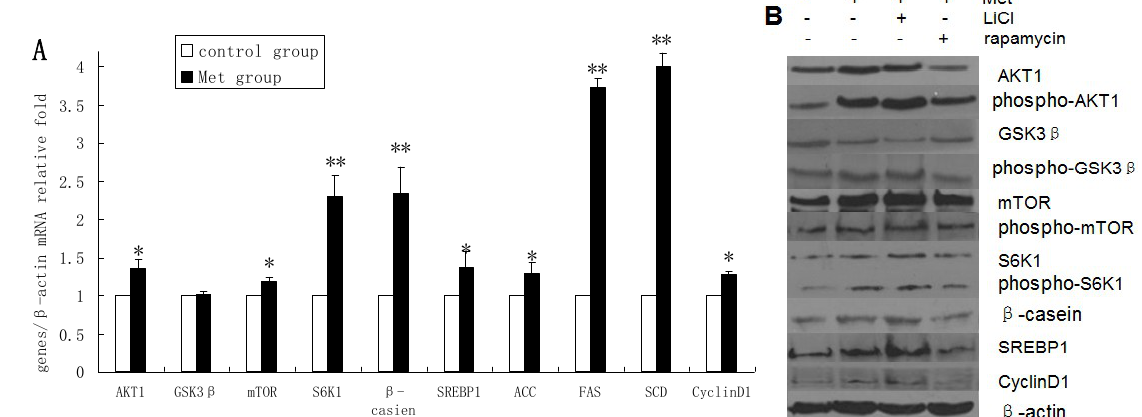
Figure 4. Assessments of gene expression, protein expression, cell viability, cell proliferation, cell cycle, and triglyceride (TG) secretion in four groups of DCMECs: control (untreated) cells, DCMECs treated with Met (0.6 mM) for 24 h, DCMECs treated with Met (0.6 mM) and LiCl (20 mM) for 24 h, and DCMECs treated with Met (0.6 mM) and rapamycin (1 nM) for 24 h. Relative mRNA levels (mRNA levels/ β -actin) were determined by qRT-PCR following Met treatment ( A ) and protein levels were assessed by western blot analysis ( B ) and quantified (proteins/ β -actin relative fold) by gray scale scan ( C ). Cell viability and cell proliferation of DCMECs were assessed using a cell counter ( D ) and cell cycle analysis was carried out using flow cytometry ( E ). The TG content in the culture supernatants of DCMECs was measured ( F ). All values represent means ± SE ( n = 3 biological replicates). * p < 0.05 and ** p < 0.01 indicate significant differences between values across two groups as